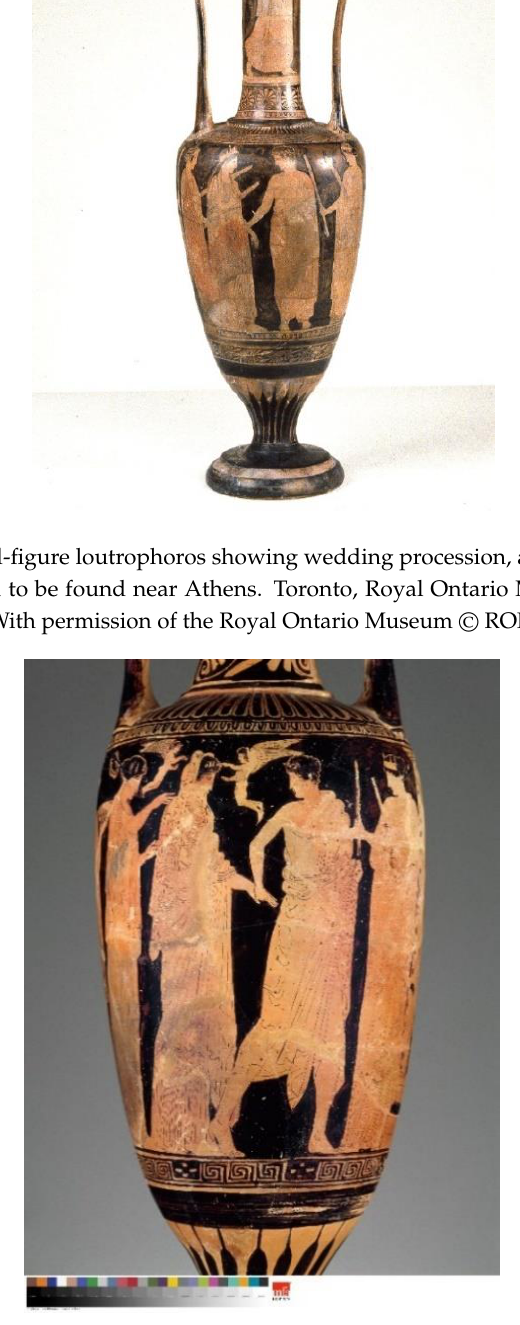
Figure 11. Athenian red-figure loutrophoros showing wedding procession, unattributed. 450–425 BCE. Vase said to be from Athens. Boston, Museum of Fine Arts 03.802, BAPD 15815. Credit: Photograph © 2019 Museum of Fine Arts, Boston.